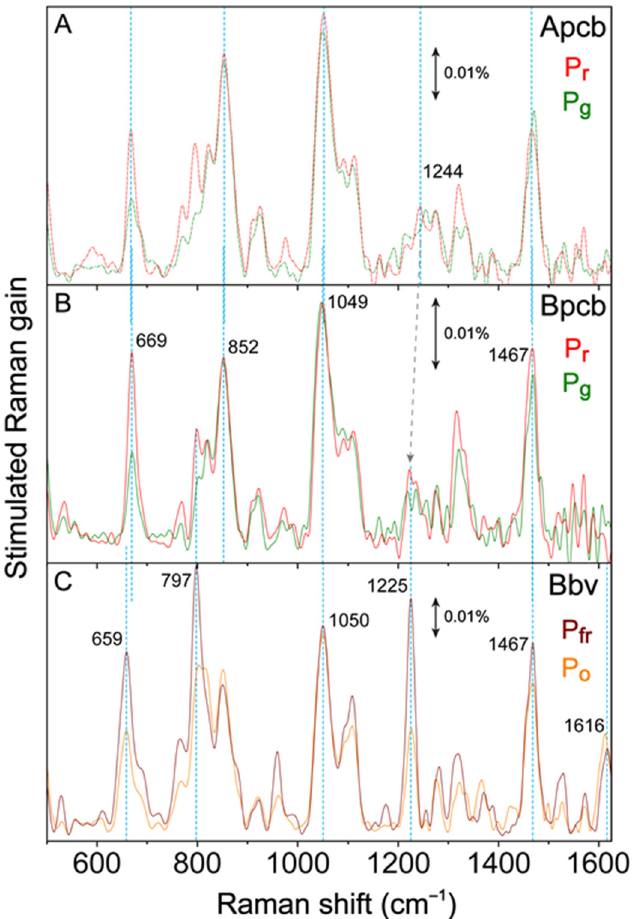
Figure 4. Raman signatures of various cofactors in related CBCR conformers. GS-FSRS spectra of ( A ) Apcb and ( B ) Bpcb P r (red) and P g (green) species using 505 and 650 nm LEDs, respectively, as well as ( C ) Bbv P fr (dark red) and P o (orange) species using 600 nm LEDs and a 650 nm longpass- filtered tungsten lamp. The ps 803 nm Raman pump was used to minimize the pump-induced conversion of the cofactor species, with the fs Raman probe set at the Stokes side. Vertical dotted lines and a dashed arrow denote the peak frequency shifts between key vibrational modes of related CBCR cofactors. The double-headed arrows denote the stimulated Raman gain magnitude of 0.01% in each panel.